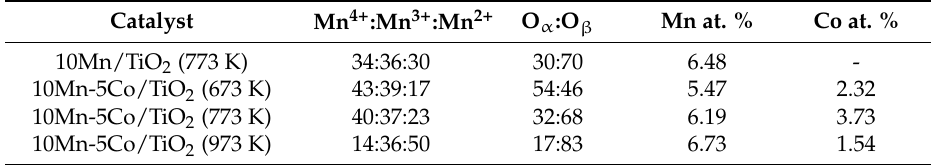
Table 2. Surface atomic concentrations and ratios for the catalysts determined by XPS spectra. Catalyst Mn 4+ :Mn 3+ :Mn 2+ O α :O β Mn at.